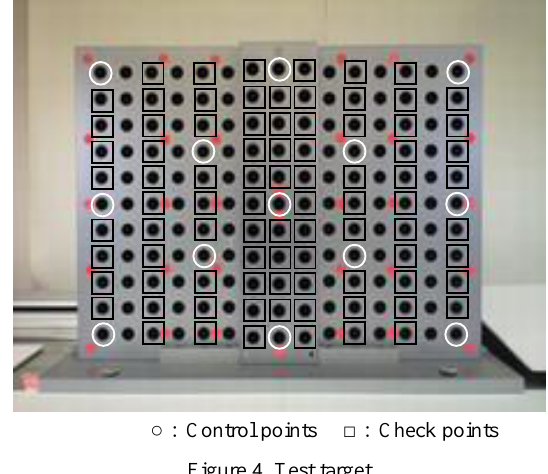
Figure 4. Test target